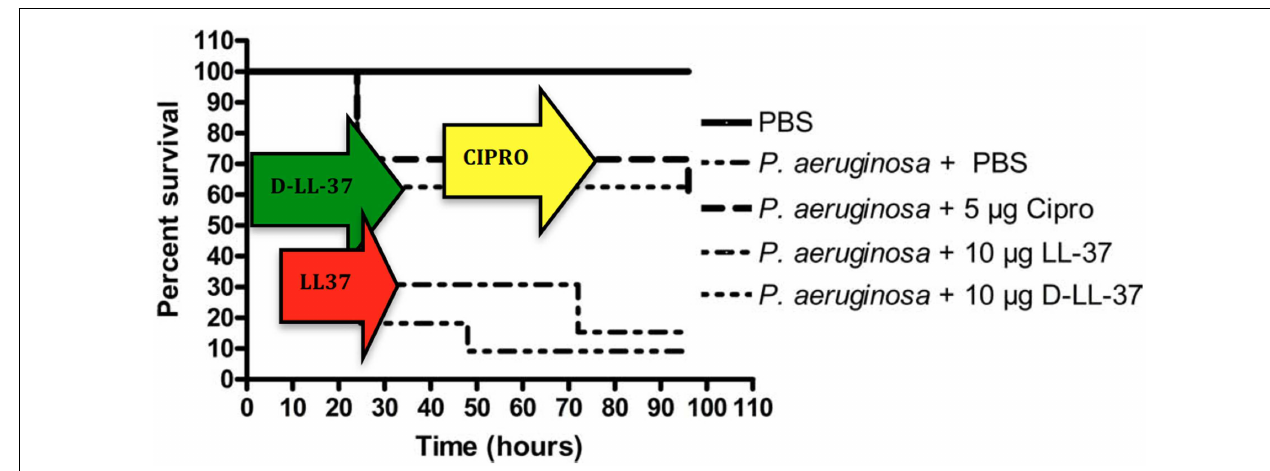
significantly different from all other groups ( p -value < 0.002).The infected group without treatment failed to survive beyond 24h. A single dose of 5 µ g ciprofloxacin, or 10 µ g of either d- or l-LL-37 was found effective when compared to the infected control group ( p -value < 0.01), but not different from each other overall. At 48h d-LL-37 was found to be more effective than l-LL-37 ( p -value < 0.04). (Figure from Dean et al., 2011a, used with